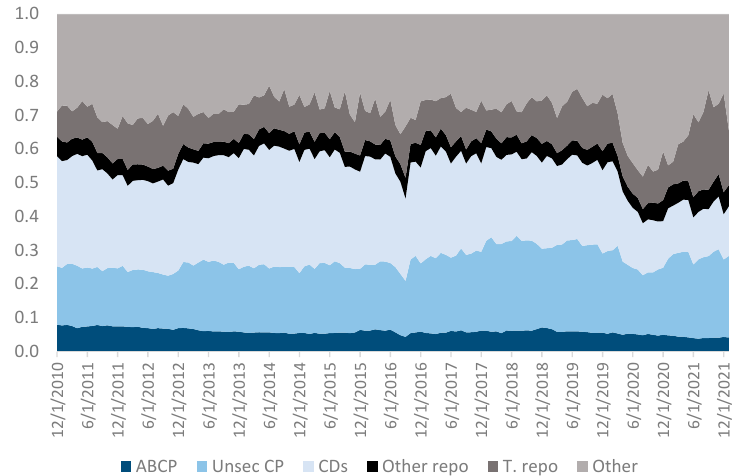
Figure 1. U.S. Prime Money Market Funds’ Investments by Instrument (as a proportion of assets under management). Source: Federal Reserve. Definitions: ABCP is asset-backed commercial paper,